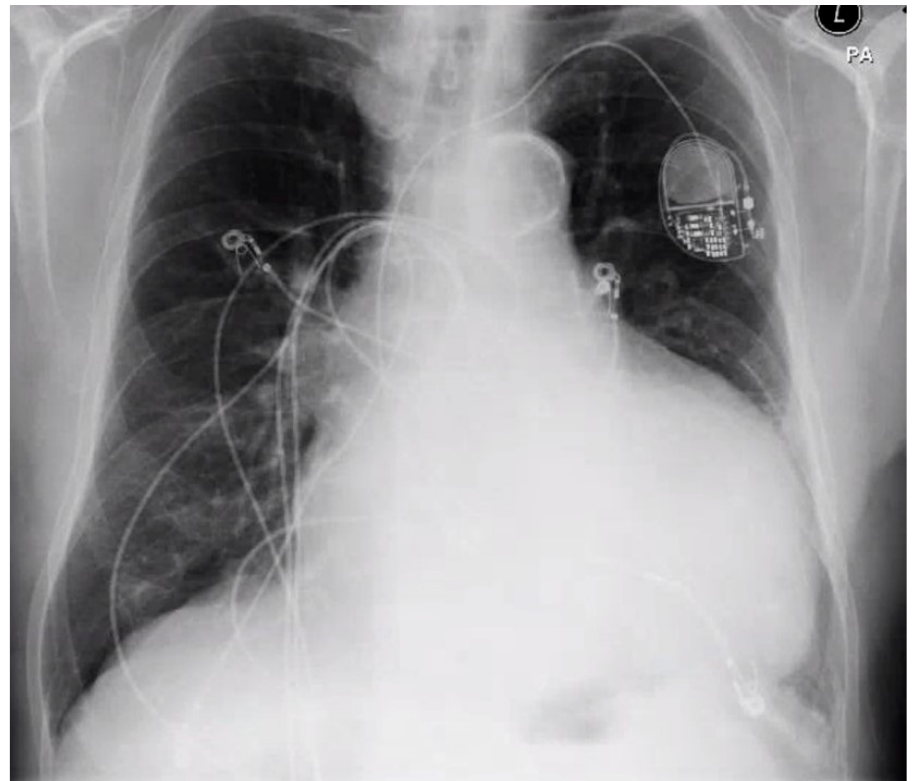
Figure 1. Chest X-ray evidencing an enlarged cardiac contour.